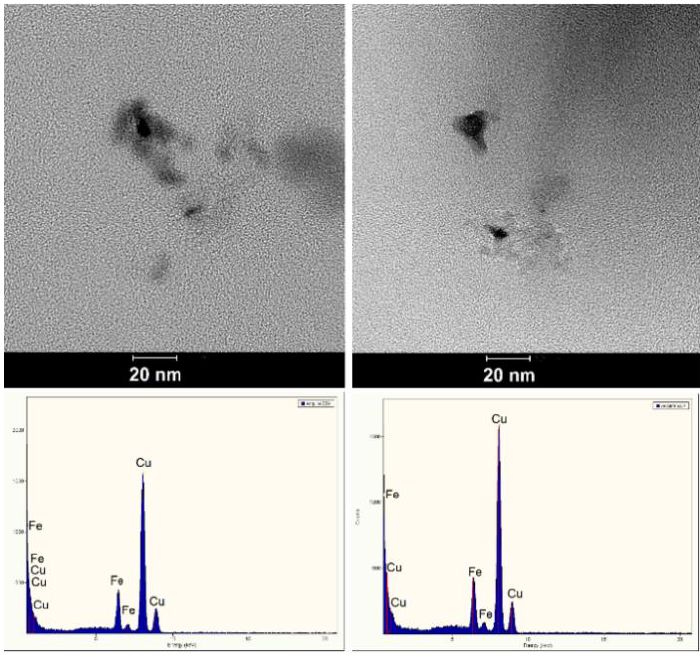
Figure 7. TEM images and EDX spectra of the crude. a. a Note: The presence of copper is due to the grid supporting the sample.